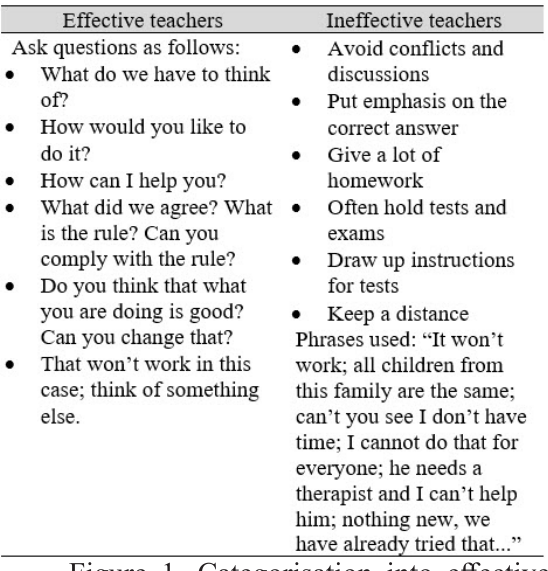
Figure 1. Categorisation into effective and ineffective